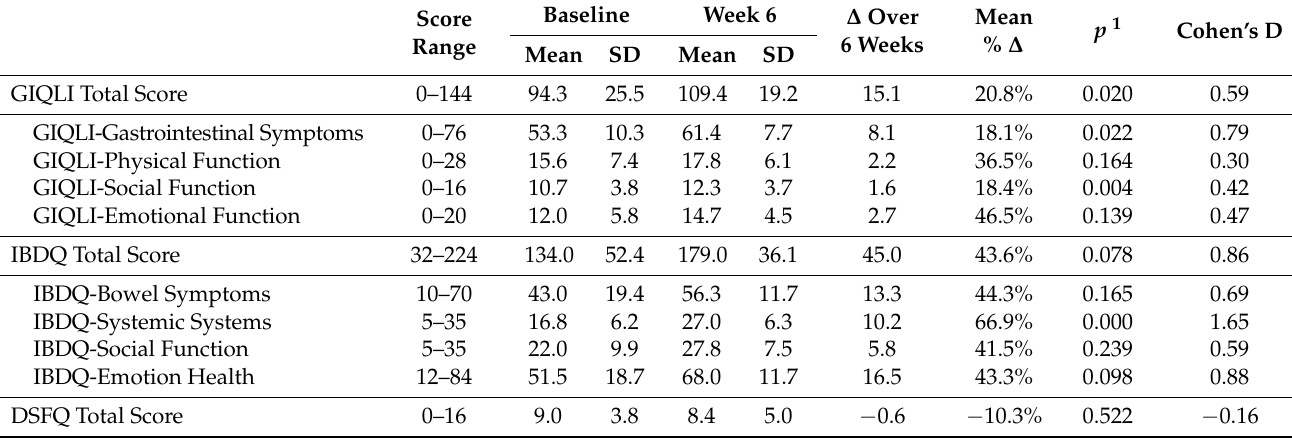
Table 4. Pilot Trial Gastrointestinal Quality of Life Questionnaire Score Changes Over 6